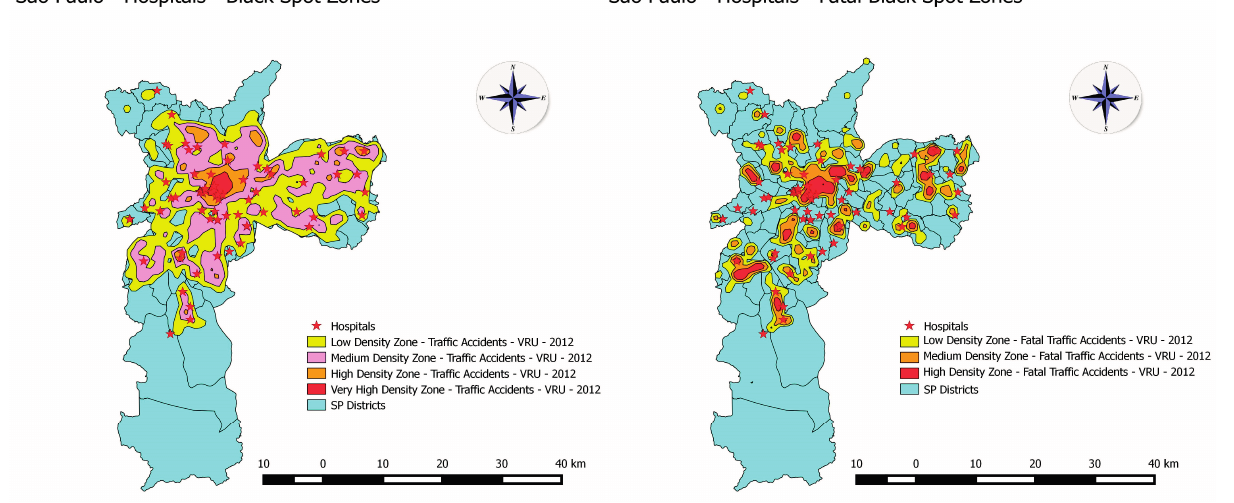
Figure 9. Hospitals/black spot: São Paulo.